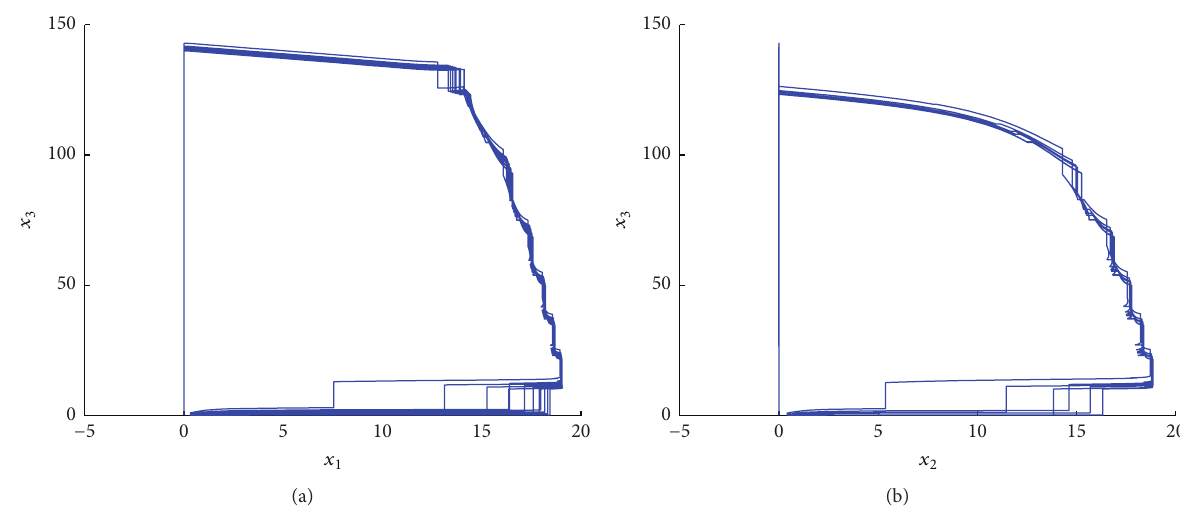
Figure 2: Dynamic behavior of the prey-eradication periodic solution with different initial values and the parameters are same as Figure 1. (a) Phase portrait of 𝑥 1 (𝑡) and 𝑥 3 (𝑡) with different initial values. (b) Phase portrait of 𝑥 2 (𝑡) and 𝑥 3 (𝑡) with different initial values.